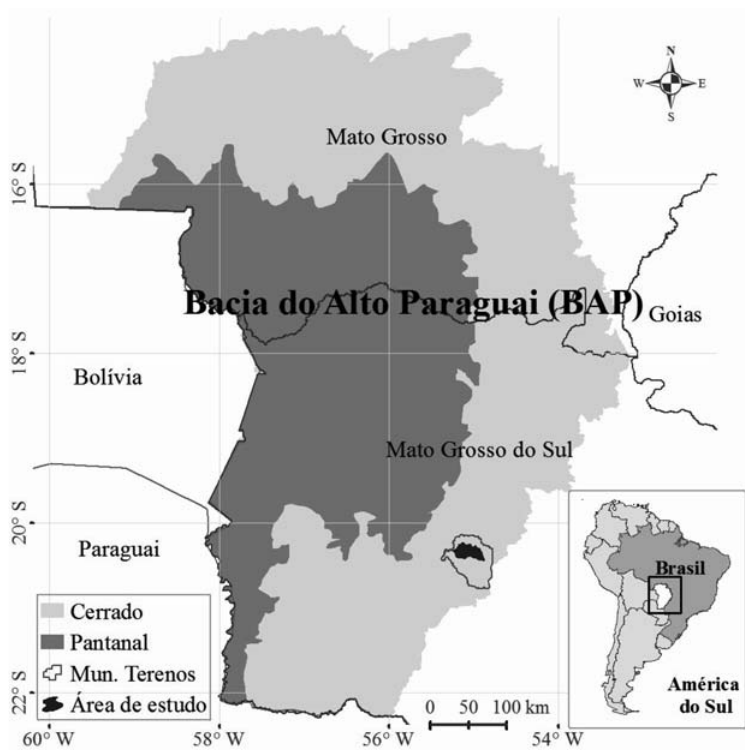
Figura 1. Área de